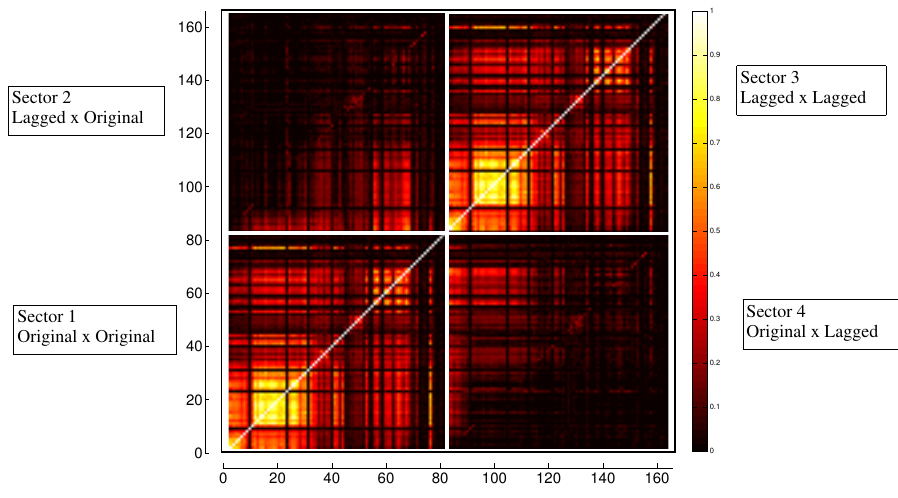
Figure 1. Heat map of the enlarged correlation matrix of both original and lagged indices, representing same-day correlation in Sector 1 and previous-day correlation in Sector